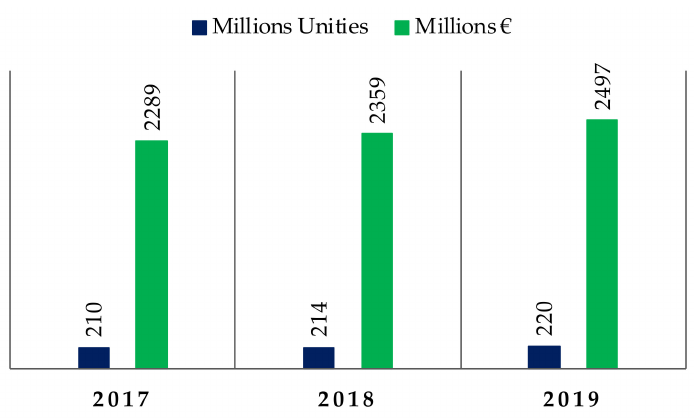
Figure 2. PhaCs evolution in Portugal between